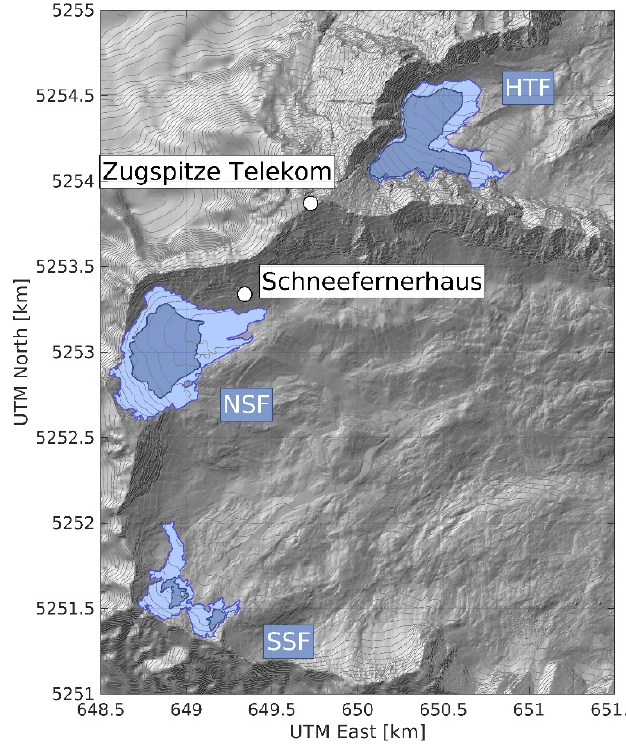
Figure 9. Map of Zugspitze plateau incl. the AG observation sites (white dots) at the summit and in Schneefernerhaus, along with areas covered by the three glaciers Höllentalferner (HTF), Nördlicher Schneeferner (NSF), Südlicher Schneeferner (SSF), at epochs 1999 (light blue) and 2018 (dark blue).